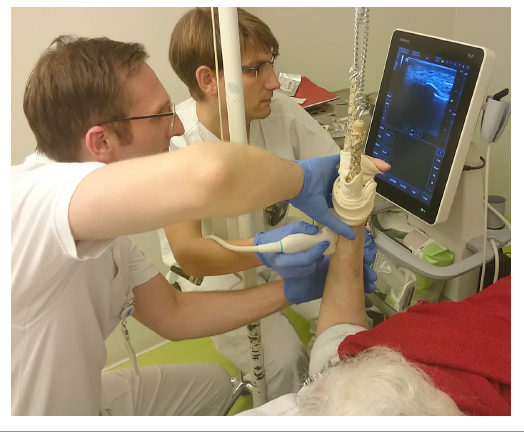
Figure 4: Ultrasound guided reposition of the distal radius fracture.